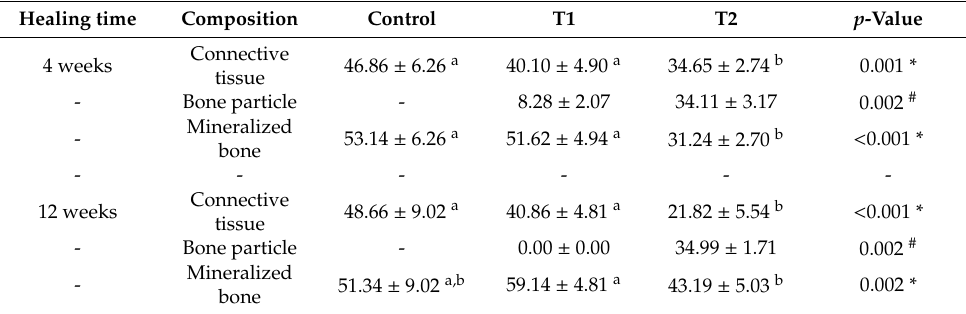
Table 3. Results of the histomorphometric analyses at 4 and 12 weeks of